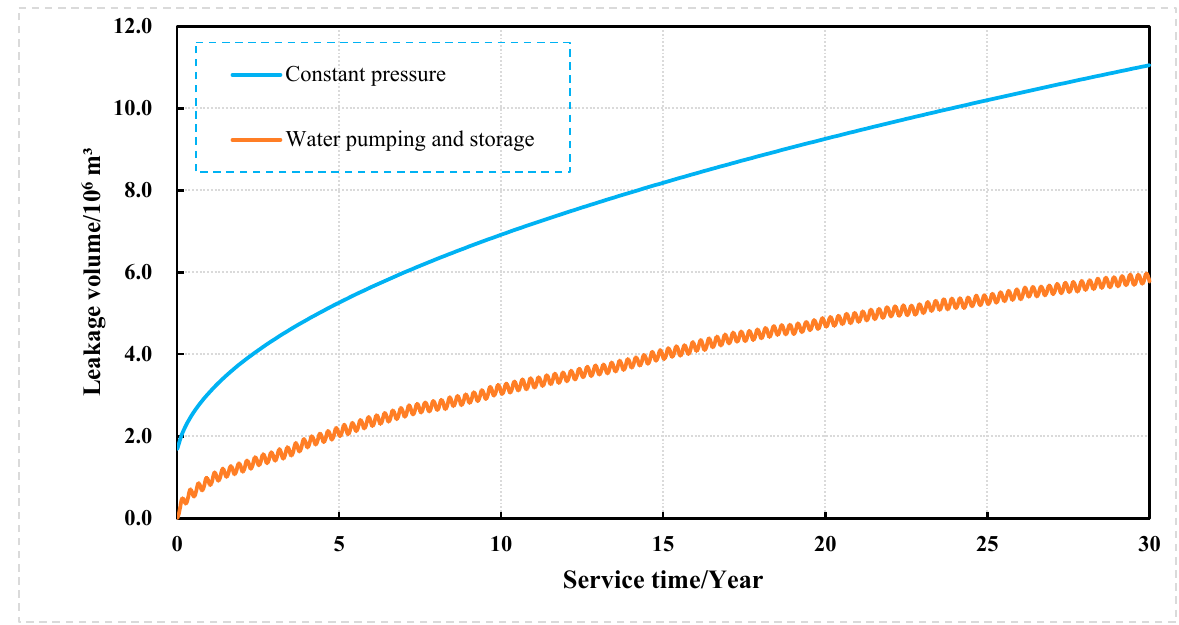
Figure 9. Cumulative leakage of reservoir with water pumping and storage.